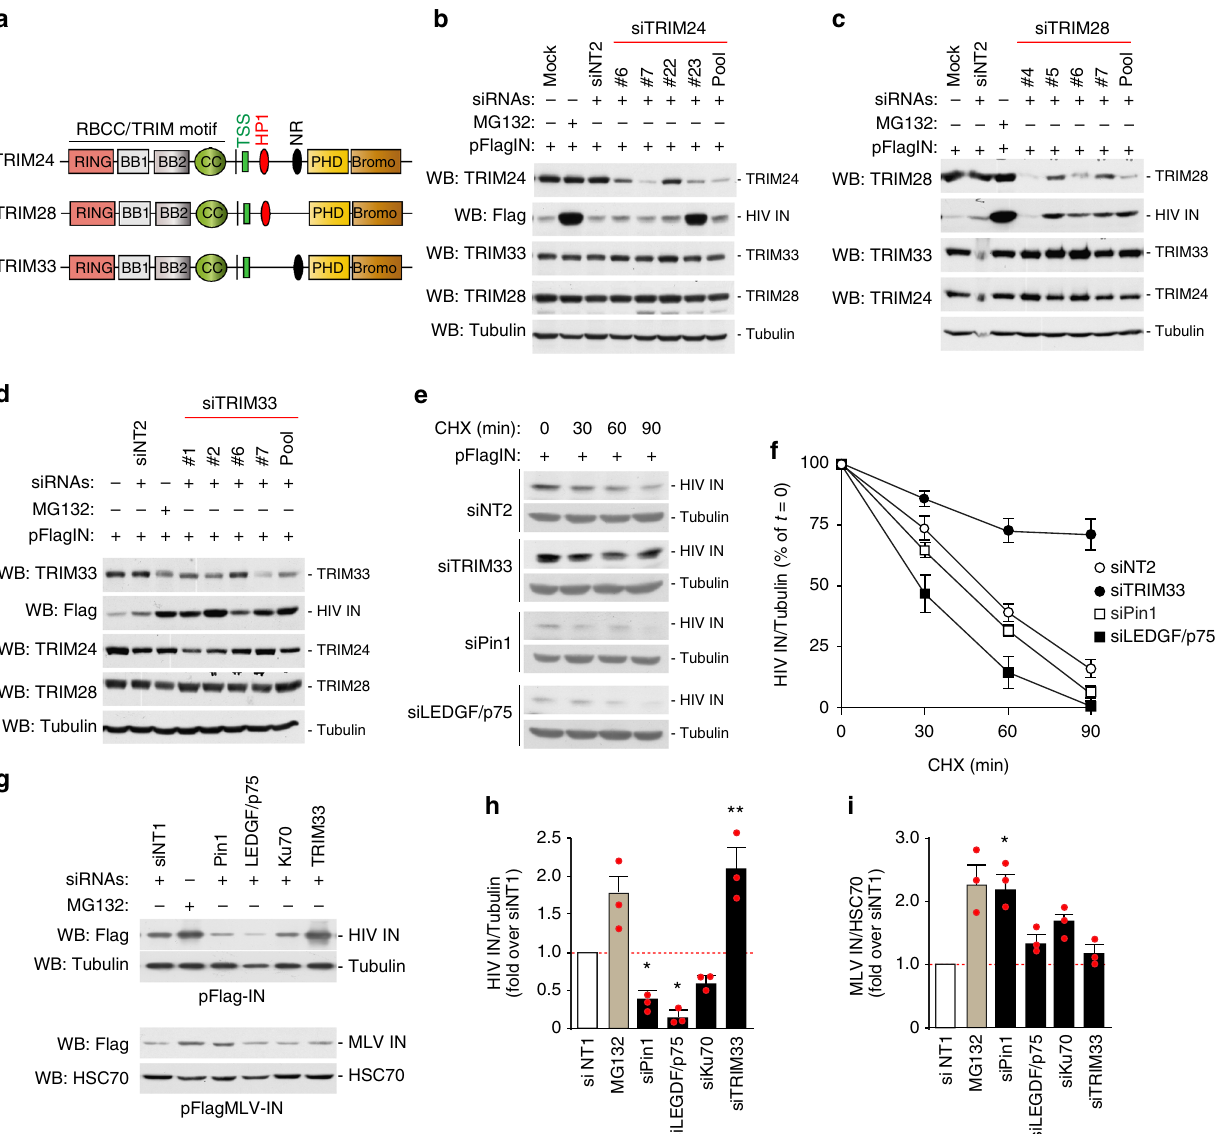
both cases), but not to the other domains of the protein (<3% binding; Fig. 4c). All the GST fusion proteins were expressed and puri fi ed at comparable levels for the GST-pull down binding assays (Coomassie blue-stained gel at the bottom of Fig. 4c).